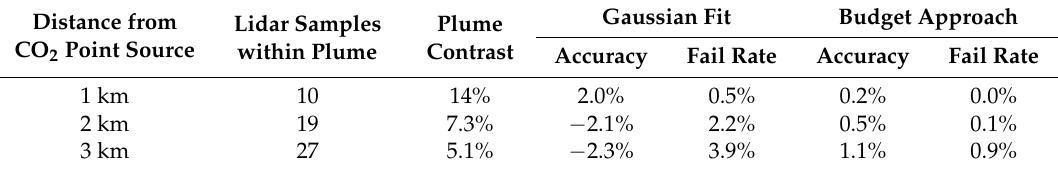
Table 5. Skill of space IPDA Lidar emission rate quantification as function of distance from the source for an ideal scenario. Plume contrast is the ratio between the maximum DAOD enhancement in the middle of the plume and the noisy background. Accuracy is the median of ( A y ’ − A y )/ A y . Fail rate indicates how often the retrieval fails to find the correct location of the plume, or does not converge (in case of Gaussian fit only). Modeling environment conditions are taken from Table